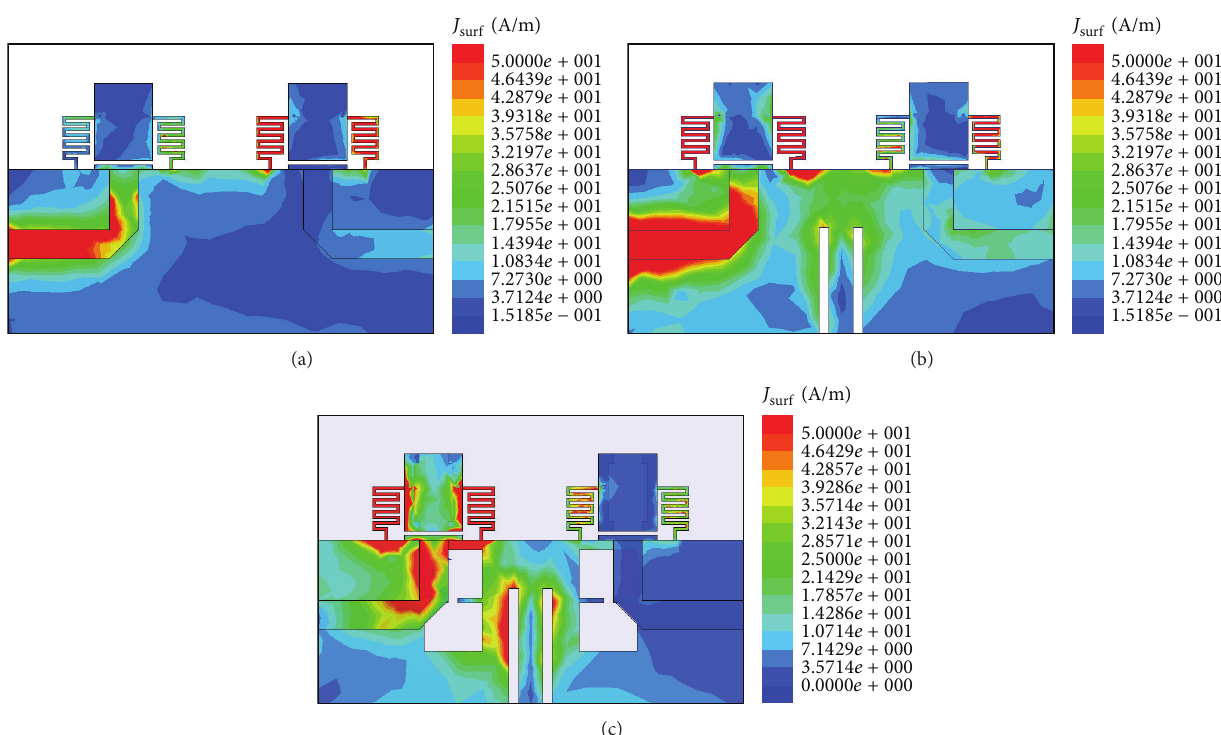
Figure 10: Surface current distribution at 2.44 GHz on metamaterial MIMO antenna (a) without DGS and (b) with the implementation of dual slots and (c) with full